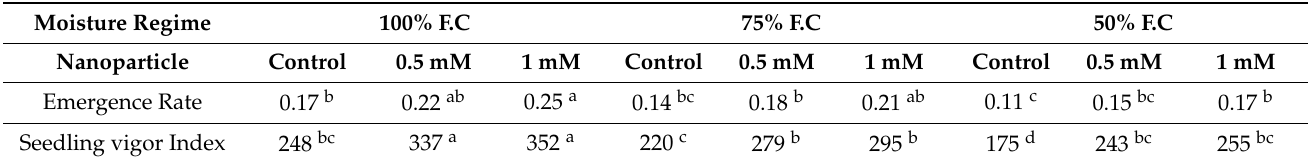
Table 7. Effect of moisture regime and nano titanium dioxide on emergence rate and seedling vigor